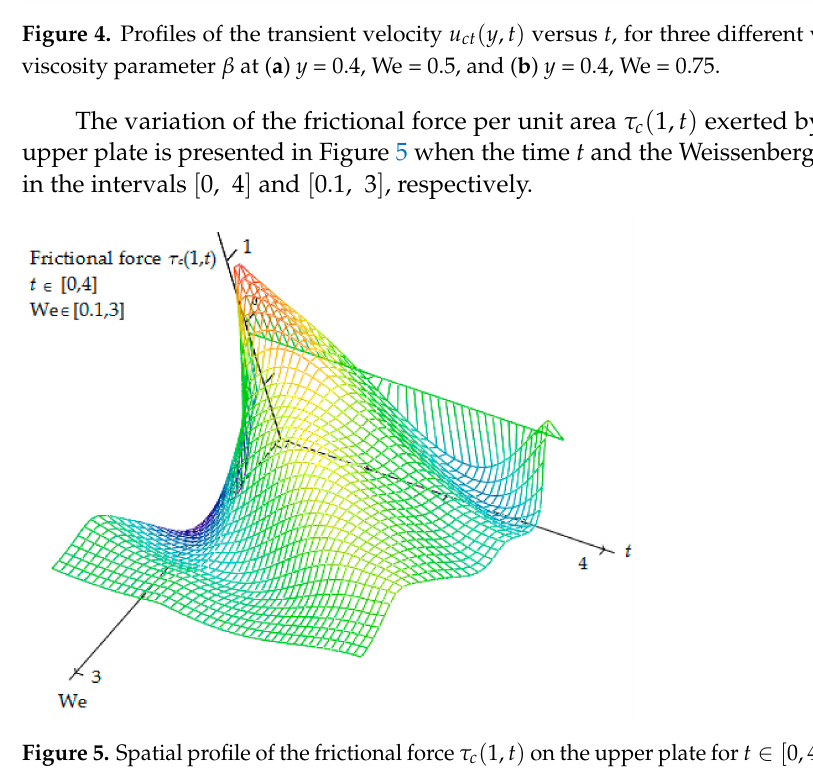
Figure 5. Spatial profile of the frictional force τ c ( 1, t ) on the upper plate for t ∈ [ 0,4 ] and We ∈ [ 0.1,3 ]